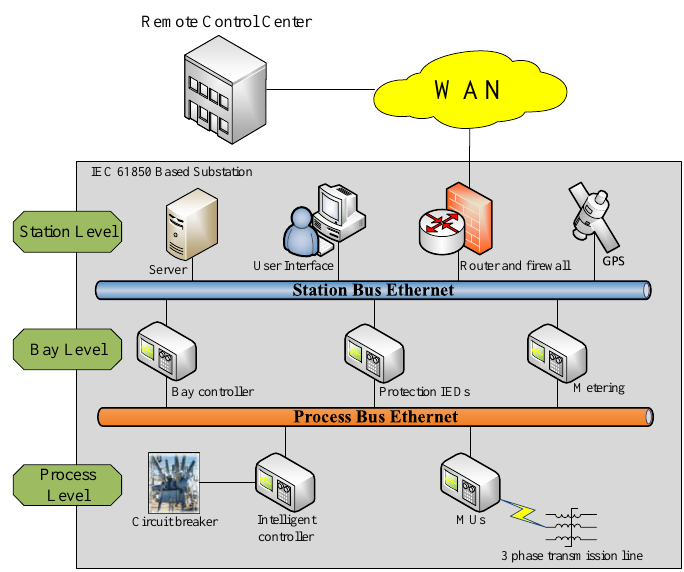
Figure 2. Architecture of an IEC 61850 based substation.